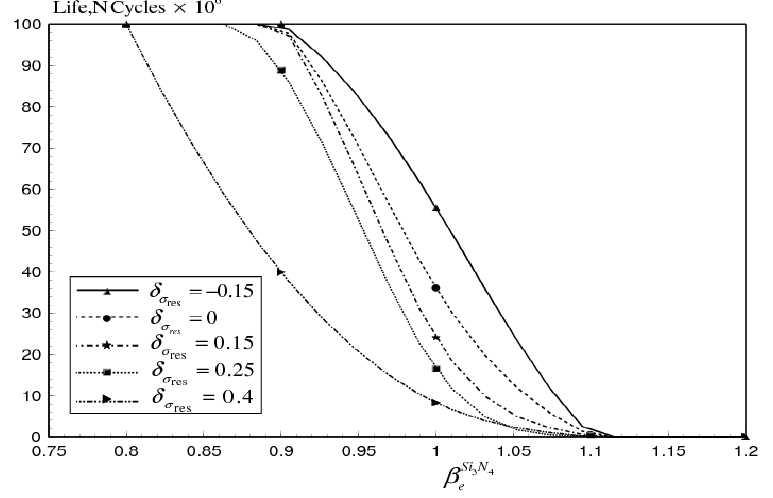
Figure 14. Effect of the variation of the coefficient of thermal expansion and deposition residual stress for Si N on the expected fatigue life of the gas sensor 3 4